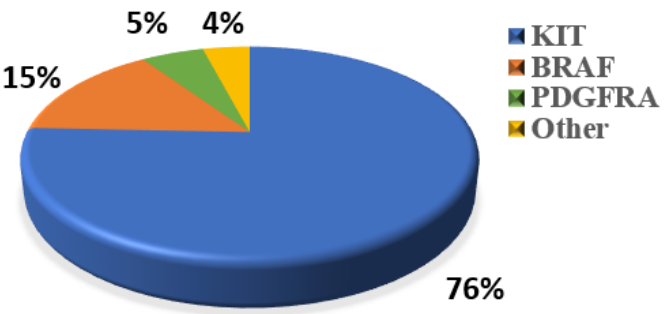
Figure 3. Percentage of classic oncogenic mutations in all 74 samples.